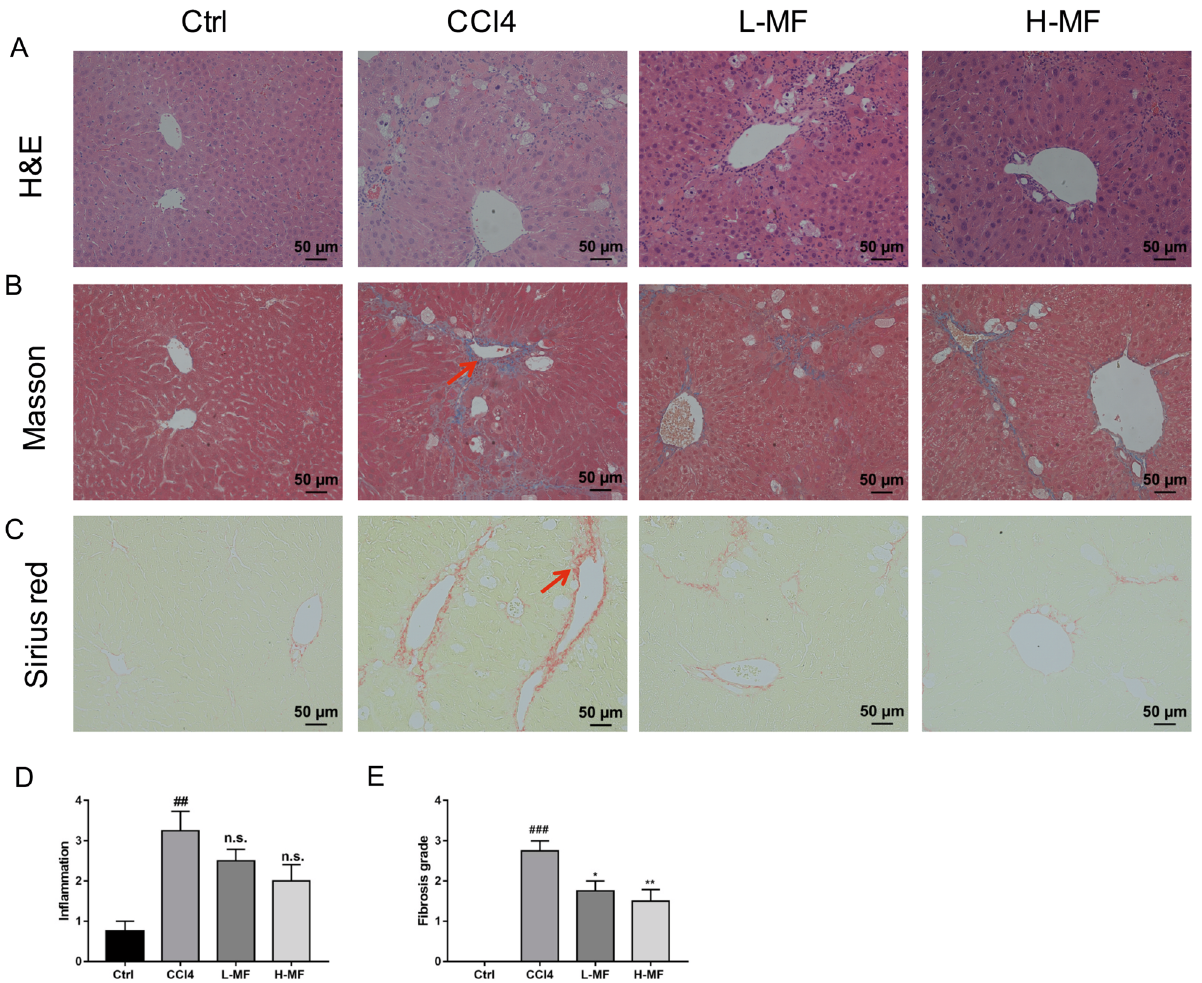
Figure 2. Effects of mangiferin on histology of the liver in CCl4 induced mice. ( A ) H&E staining. ( B ) Masson’s trichrome staining. Red arrows indicated damaged liver tissue and fiber cords. ( C ) Sirius red staining. ( D ) The analysis of inflammation in H&E staining. ( E ) The analysis of fibrosis grade in Masson’s trichrome staining. Date are presented as means ± S.E.M. (n = 8). ## p < 0.01 and ### p < 0.001, compared with control group. * p < 0.05 and ** p < 0.01, compared with CCl4 group. Ctrl, control group; Ctrl, control group; CCl4, carbon tetrachloride treated group; L-MF, low dose of mangiferin (50 mg/kg); H-MF, high dose of mangiferin (100 mg/kg).